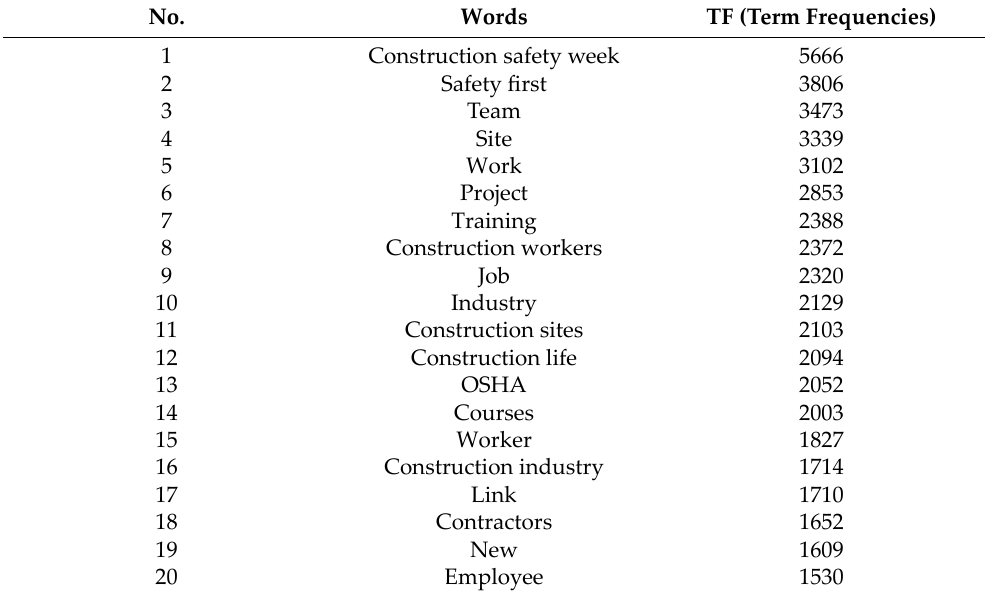
Table 1. The top 20 keywords with higher term frequencies in construction health and safety on